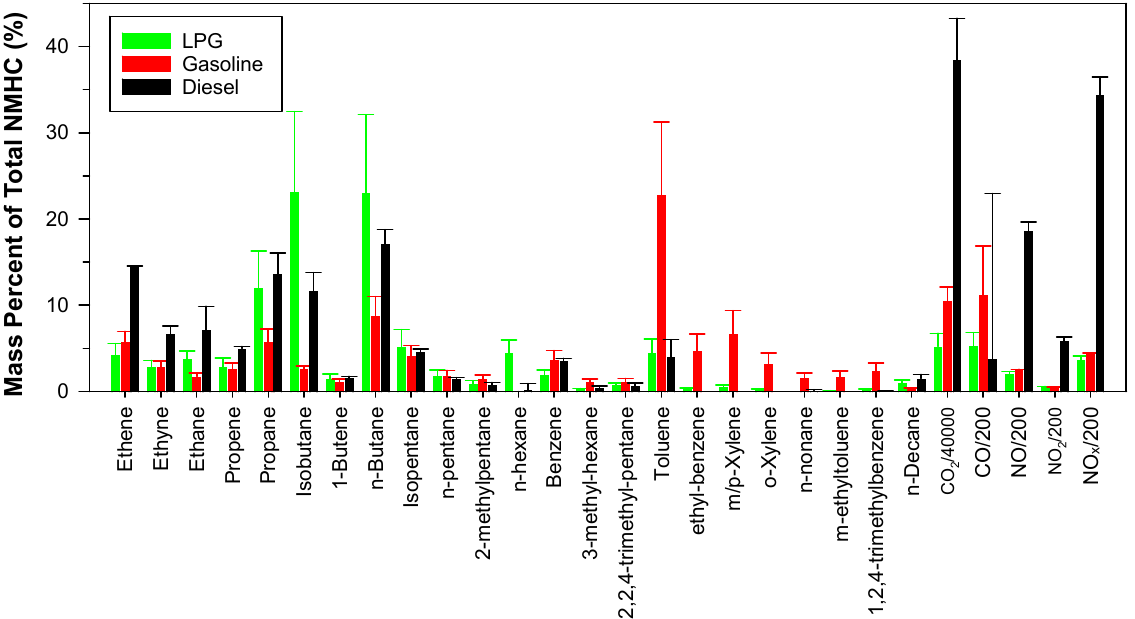
Figure 3. PMF-derived gas and NMHC factors associated with LPG, gasoline, and diesel vehicles. Only species with abundances >1% of total measured NMHC mass are shown for clarity. Error bars indicate the standard deviation from 10 replicate model runs.